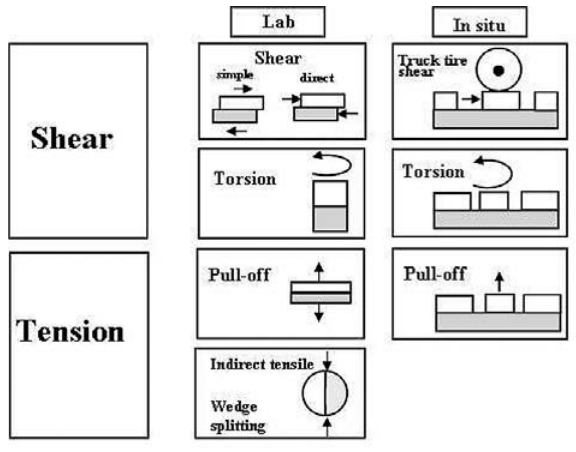
Fig 3. Test methods to determine interlayer bond properties in the lab and in the field (Raab, Partl